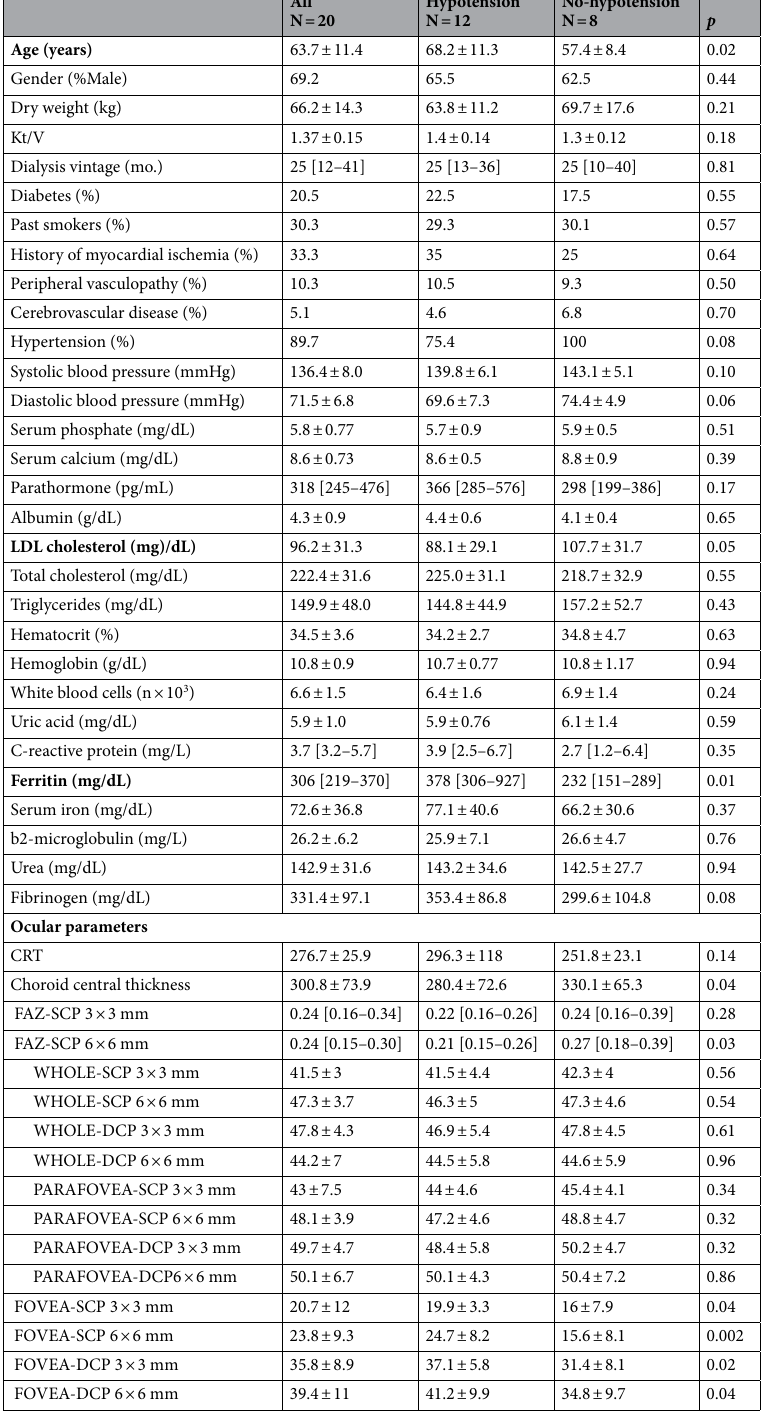
Table 1. Main laboratory and clinical characteristics of the whole study population and differences between subgroups. CRT central retinal thickness, FAZ foveal avascular zone, DCP deep capillary plexus, SCP superficial capillary